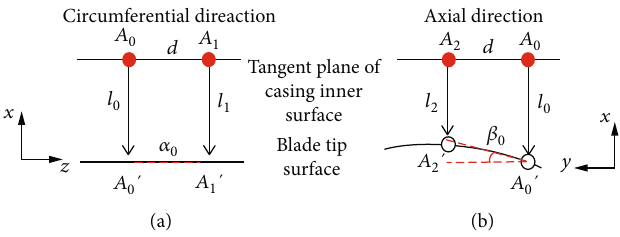
Figure 4: Schematic of the initial values of α of α . (b) Schematic of β 0